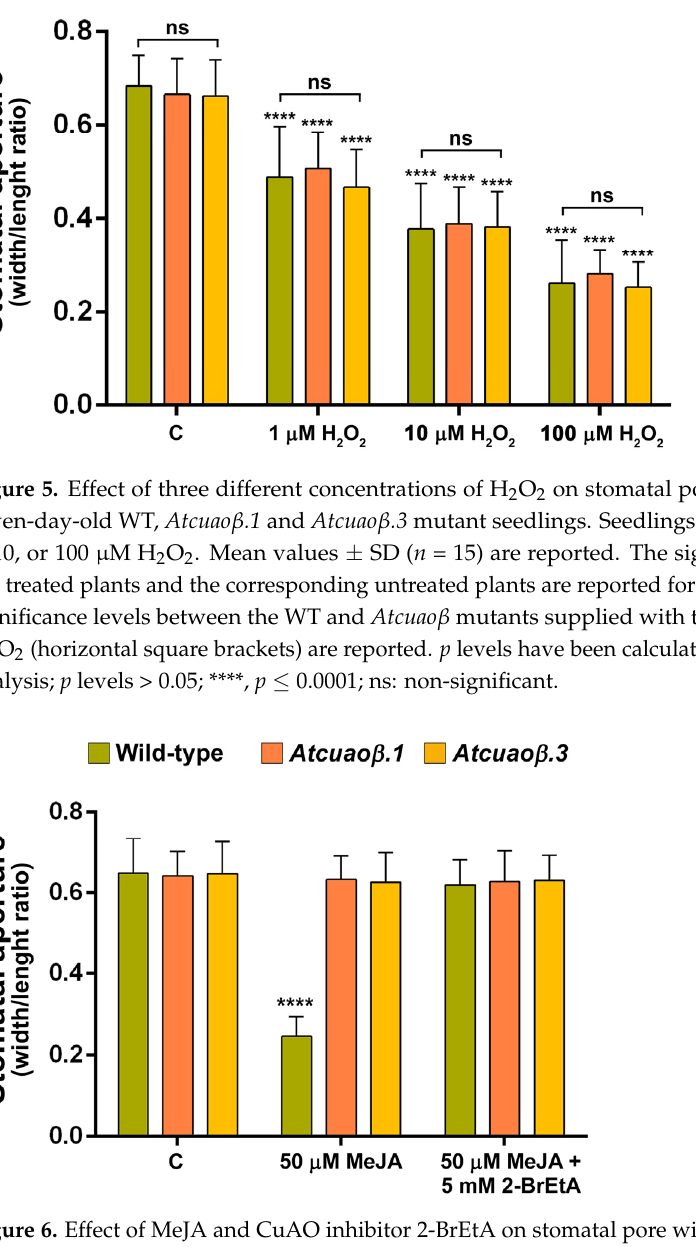
Figure 6. Effect of MeJA and CuAO inhibitor 2-BrEtA on stomatal pore width/length ratio of seven- day-old WT, Atcuao β .1 and Atcuao β .3 mutant seedlings. Seedlings were treated for 1 h with 50 µ M MeJA alone or in combination with 5 mM 2-BrEtA. Mean values ± SD ( n = 15) are reported. The significance levels between WT control plants and WT treated plants are reported. p levels have been calculated with one-way ANOVA analysis; p levels > 0.05; ****, p ≤ 0.0001.